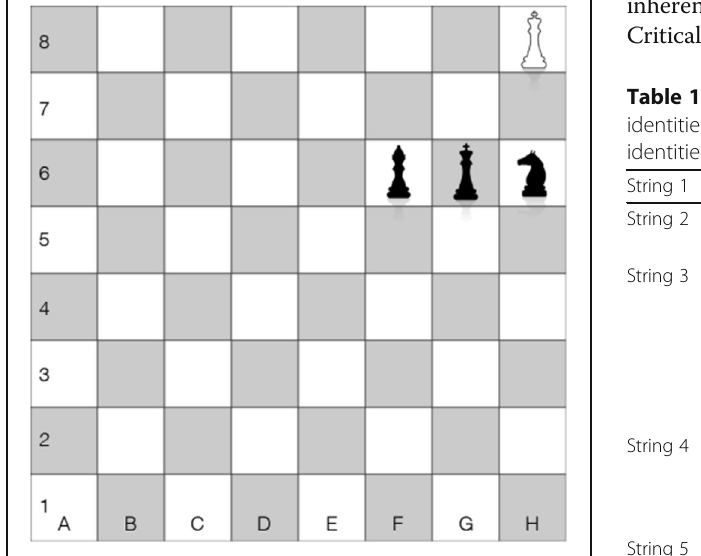
Fig. 1 Chessboard configuration of bishop and knight mate checkmate pattern